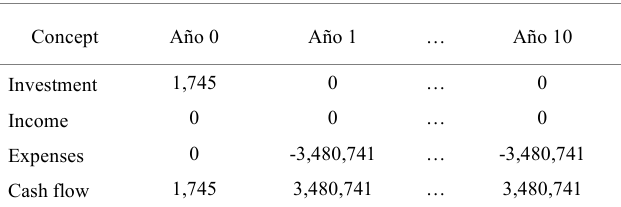
Table 7. Differential cash